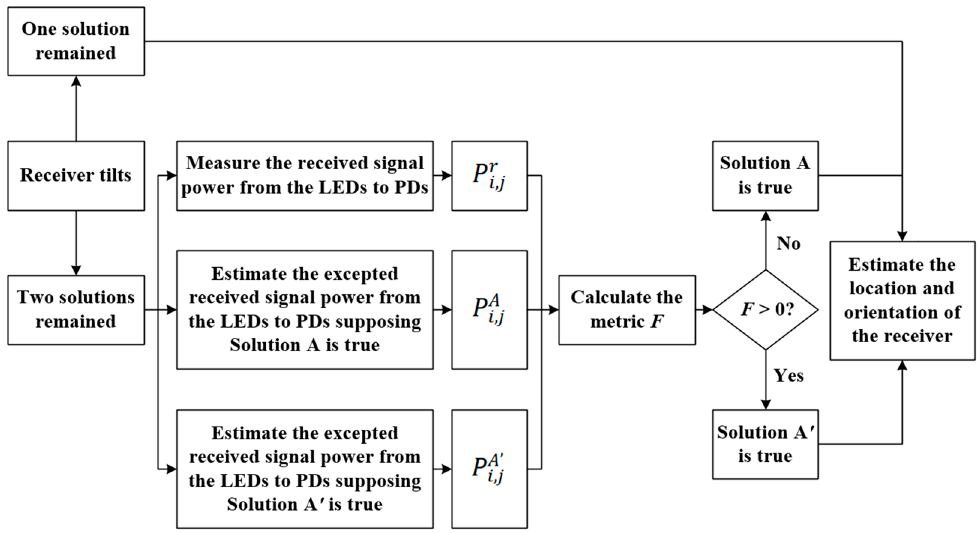
Figure 3. Flow chart of location selection